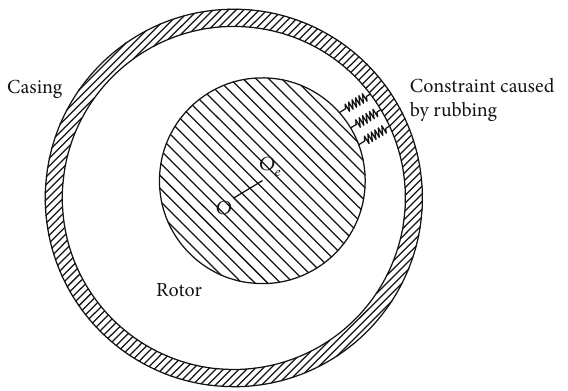
Figure 17: Displacement response of simulated aeroengine with a variable-sti ff ness fusing structure.